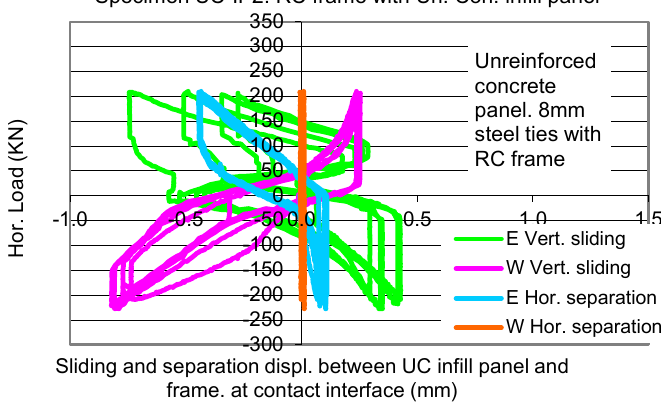
Specimen UC-IP2: RC frame with Un. Con. infill panel